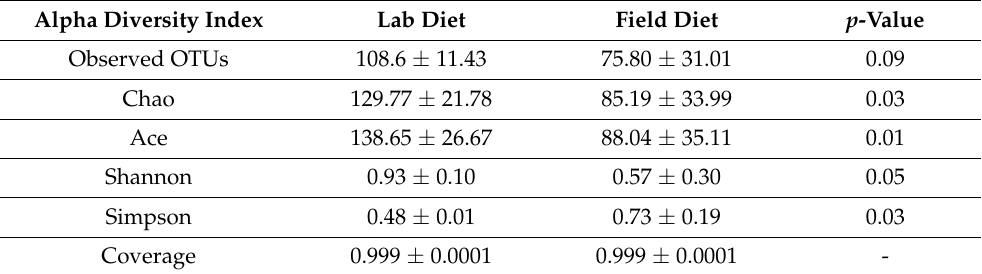
Table 1. Comparison of α -diversity indices of gut microbiota from the “lab diet” and “field diet” groups *.